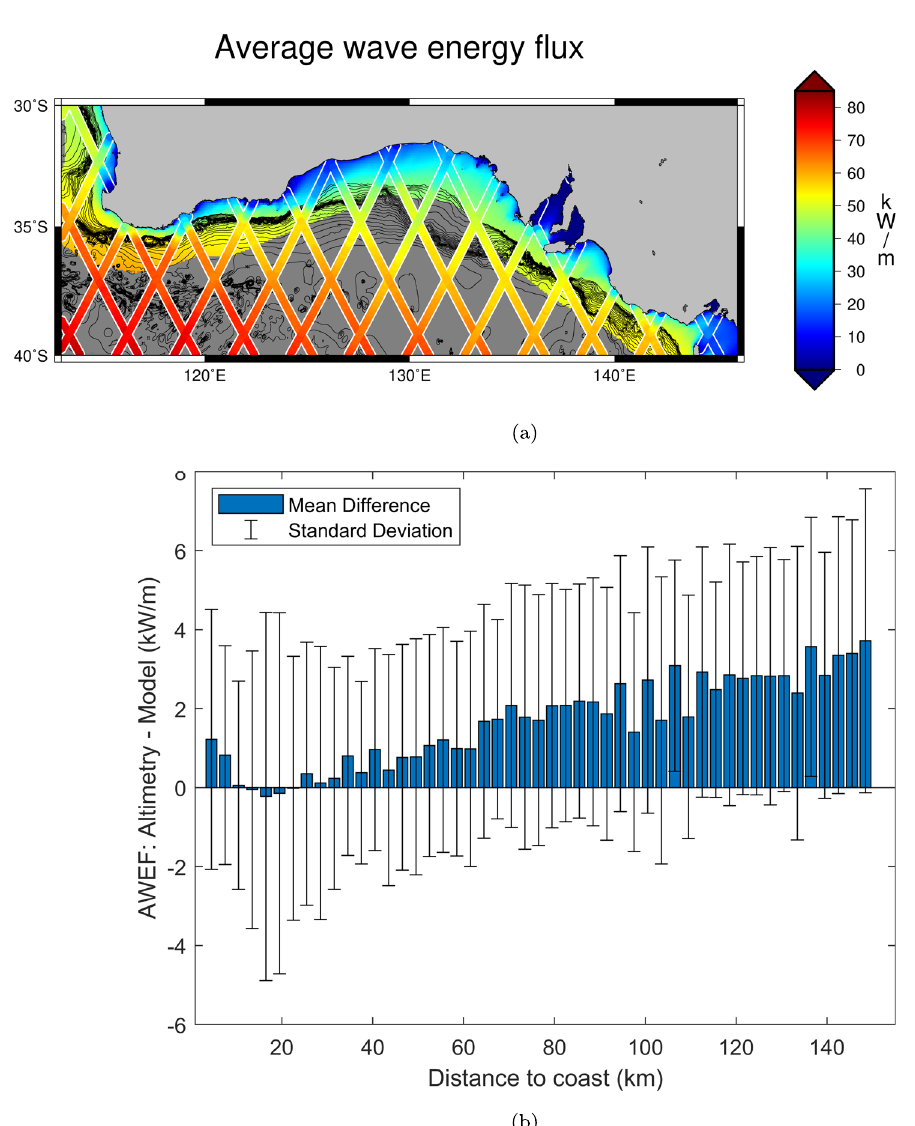
Fig. 5 Coastal average wave energy fl ux in South Australia. Average wave energy fl ux (AWEX) along the altimetry tracks in South Australia superimposed over the 50th percentile of wave energy fl ux computed using model data 23 ( a ). Mean difference (blue bars) and standard deviation of the differences (error bars) between colocated altimetry and model locations with respect to the distance to coast binned every 3 km ( b ).